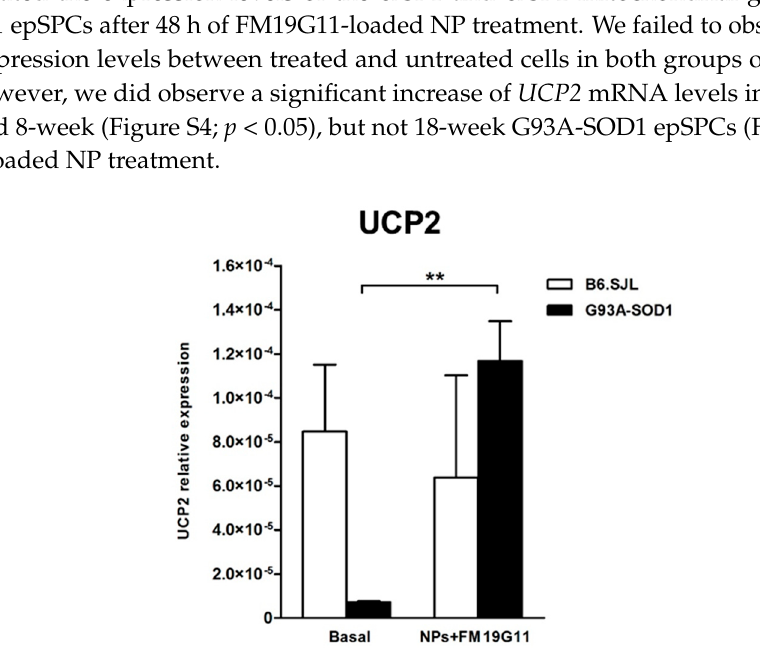
Figure 4. Analysis of UCP2 Expression Following FM19G11-loaded NP treatment. qRT PCR expression analysis of UCP2 in 12-week B6.SJL (white bars) and G93A-SOD1 (black bars) epSPCs after 48 h of FM19G11-loaded NP treatment compared to basal conditions. Expression levels reported as mean ± SD of 2 − ∆ CT values normalized against the endogenous control 18S ( n = 5 different primary cell cultures from five animals per group). ** p < 0.01 by ANOVA followed by Bonferroni post-hoc test.